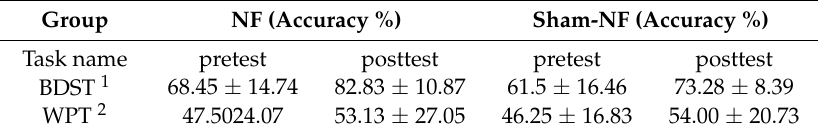
Figure 6. Changes in the accuracies of the backward digit span task and word pair task before and Figure 6 after training in two groups. ( a ) Accuracy in the backward digit span task of two groups; * represents ( p < 0.05) across group and # represents ( p < 0.05) within group; ( b ) Accuracy in the word pair task of two groups. The horizontal line in each box indicates the mean of the value of response time in each group. The hollow circles represent individual data. Table 3. Mean accuracies (standard deviations) according to memory task for each